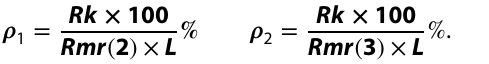
Fig. 5 Correlation between the sliding-contact factors η and